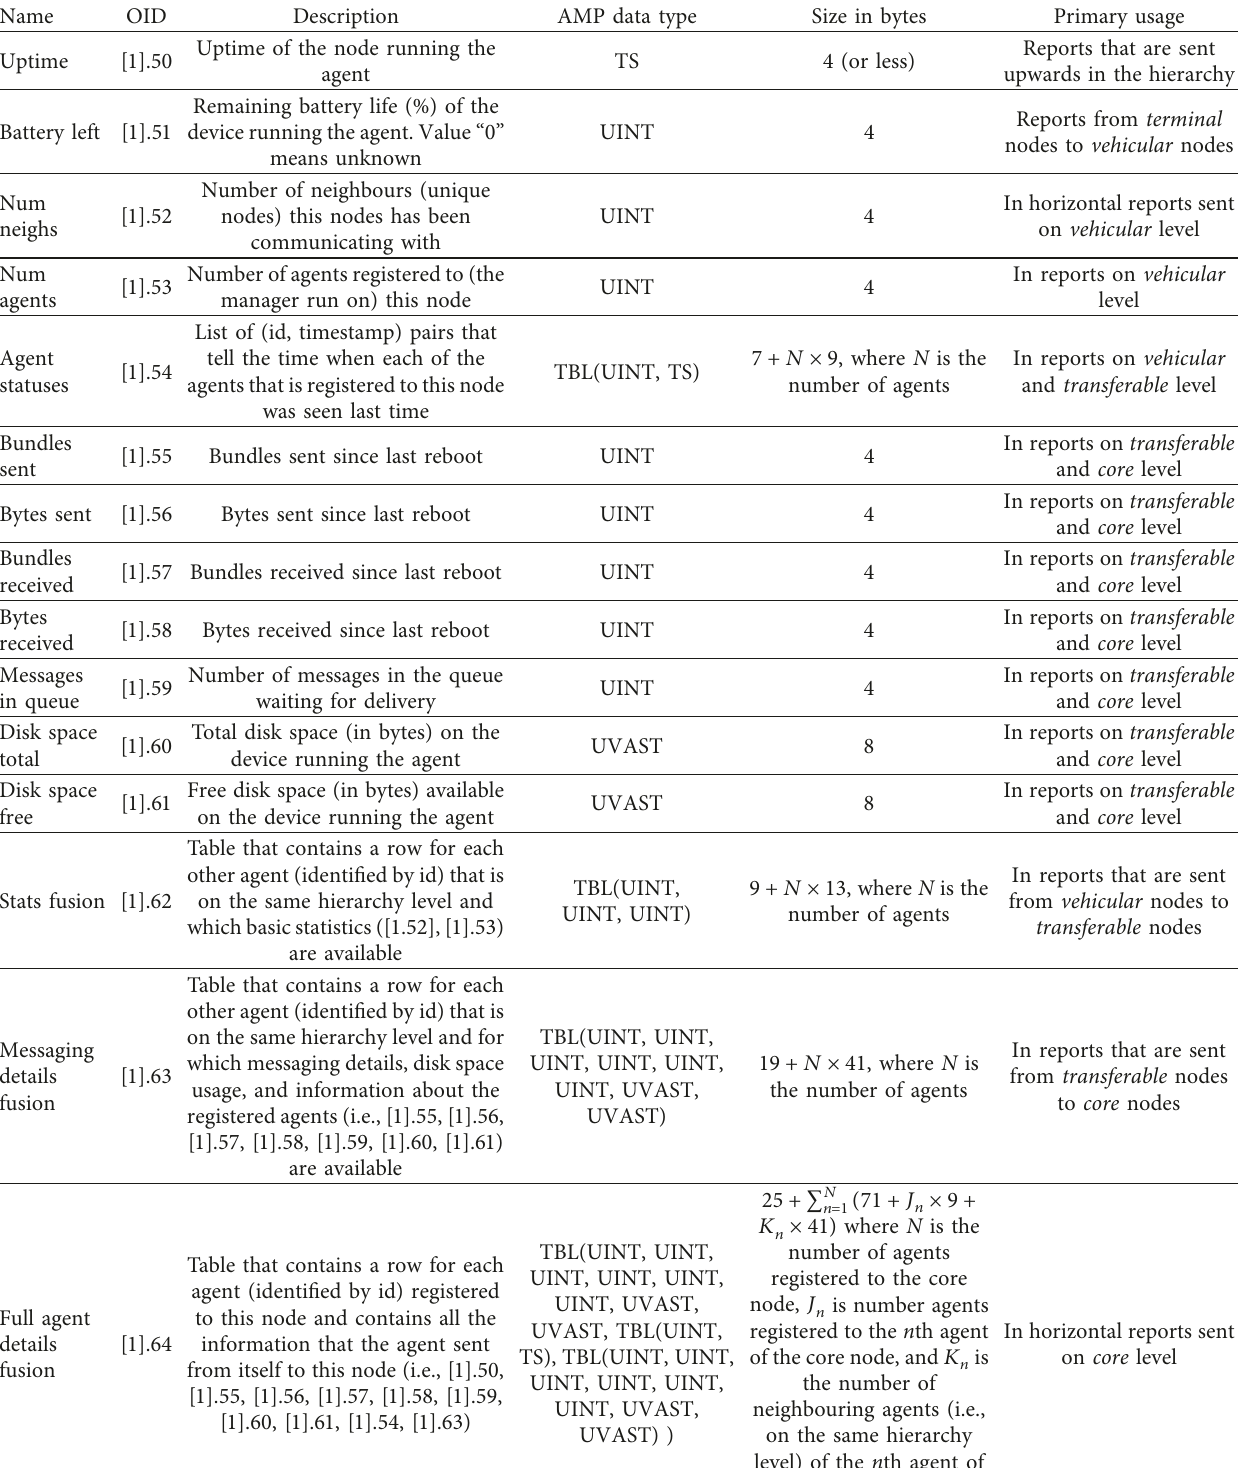
Table 3: AMP Agent ADM EDD extension for hierarchical